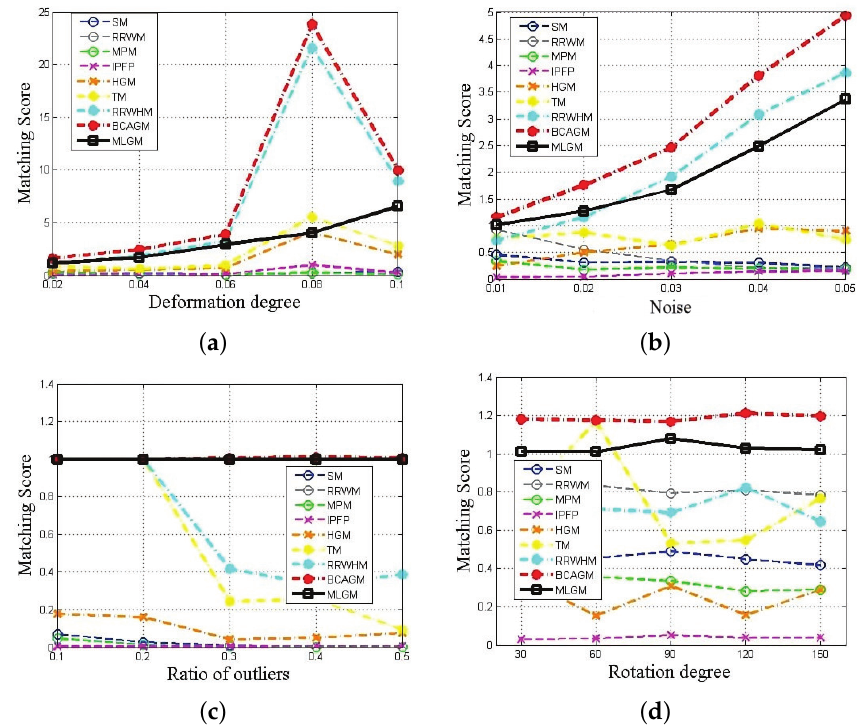
Figure 8. Matching scores of MLGM and other existing methods for the blessing synthetic point sets. Figure 9. Matching score comparison on the Blessing dataset. ( a ) Matching score with different degree of deformation. ( b ) Matching score with different noise level. ( c ) Matching score with different number of outliers. ( d ) Matching score with different rotation